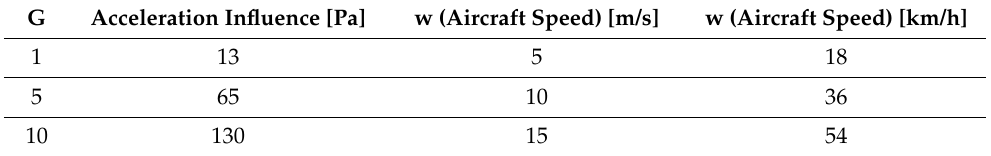
Table 2. Examples parameters of the influence of acceleration on the measurement of airplane speed.